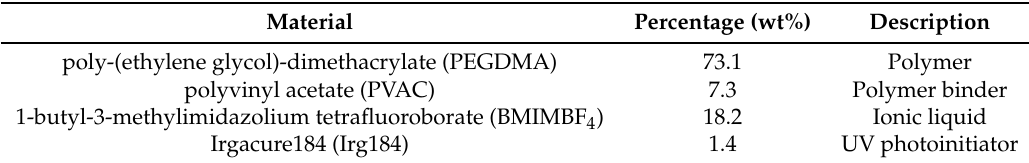
Table 1. Composition of the sample